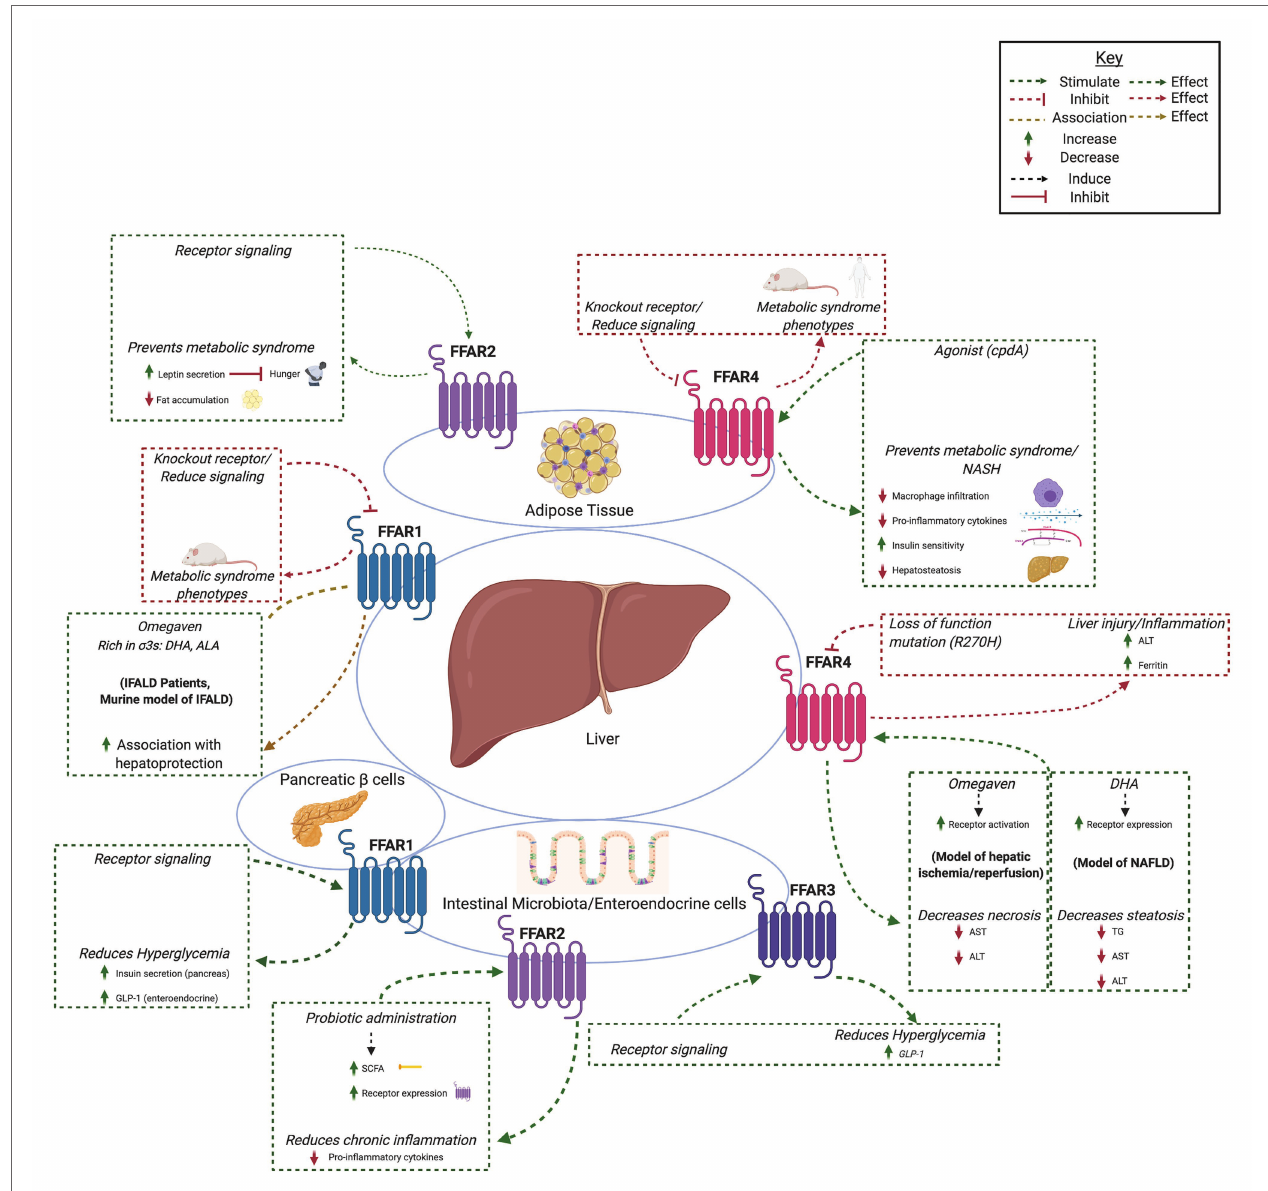
FIGURE 2 | Summary of hepatic effects of free fatty acid receptor (FFAR) signaling. FFAR1-4 each stimulates complex signaling pathways that affect gastrointestinal hormone secretion, carbohydrate and lipid metabolism, adipocyte differentiation, and immunomodulation. Common themes include FFAR knockout and antagonism associated with metabolic syndrome and liver injury (red boxes and arrows) and increased FFAR expression, signaling, or agonism associated with hepatoprotection, decreased hyperglycemia, and anti-inflammation (green boxes and arrows). Created with Biorender.com